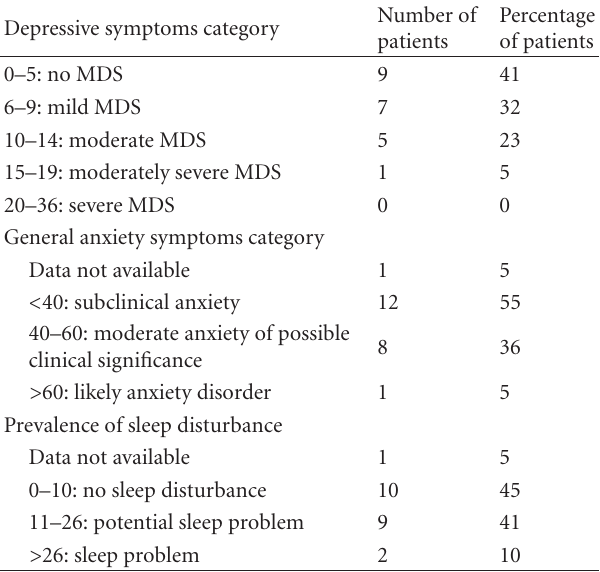
Table 3: Prevalence of depressive symptoms, general anxiety, and sleep disorders in pancreatic cancer patients. MDS: major depressive